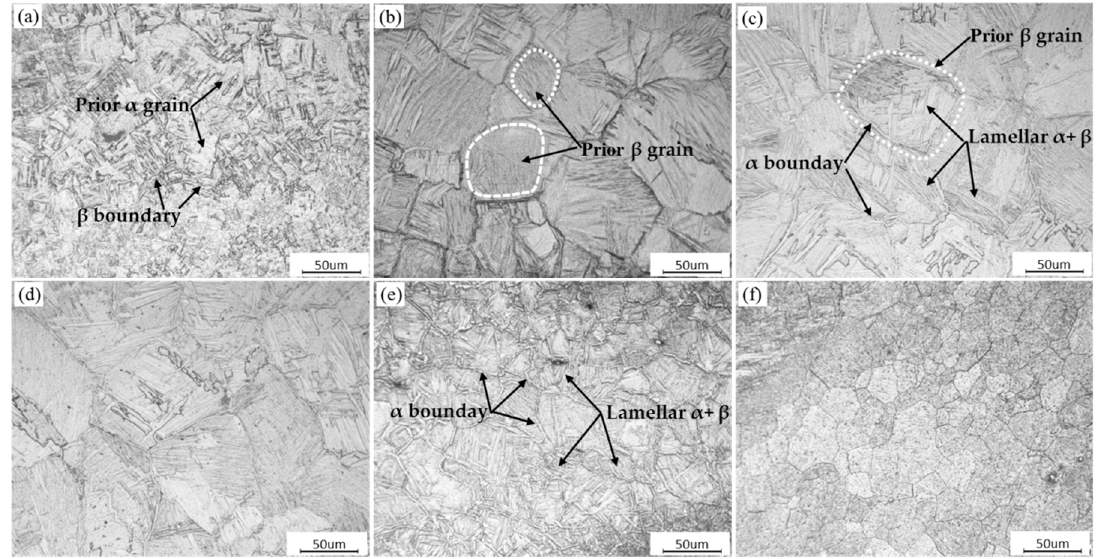
Figure 10. Micrographs of SZ. ( a ) At 700 rpm—10 mm/min, ( b ) at 900 rpm—10 mm/min, ( c ) at 1100 rpm—10 mm/min, ( d ) at 900 rpm—20 mm/min, ( e ) at 900 rpm—40 mm/min, ( f ) at 900 rpm—60 mm/min.